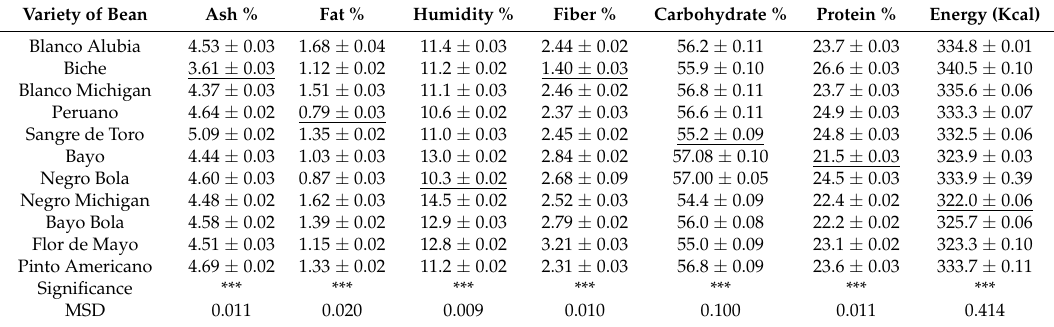
Table 4. Physicochemical composition of bean varieties produced and consumed in the state of Oaxaca